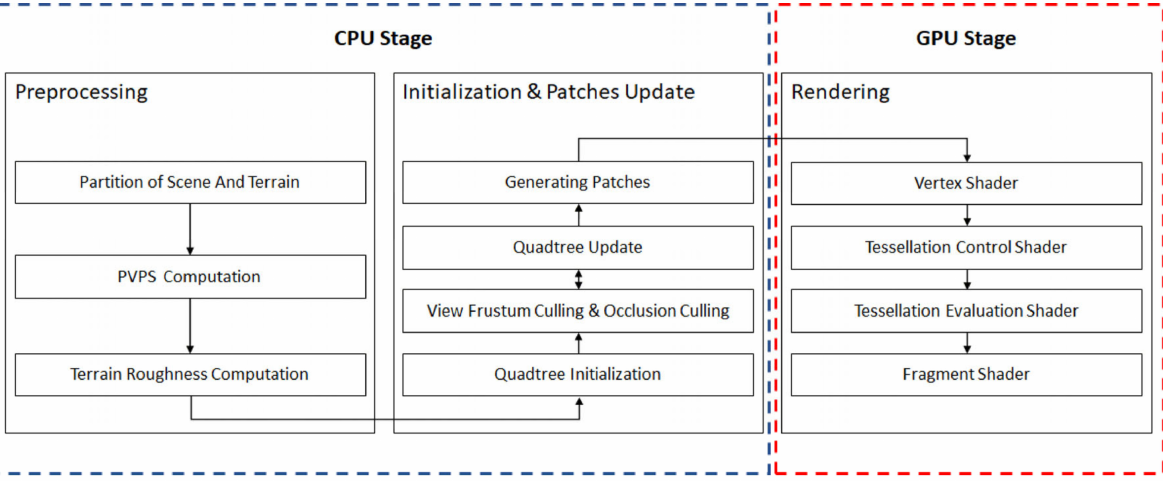
Figure 1. Process of our method.